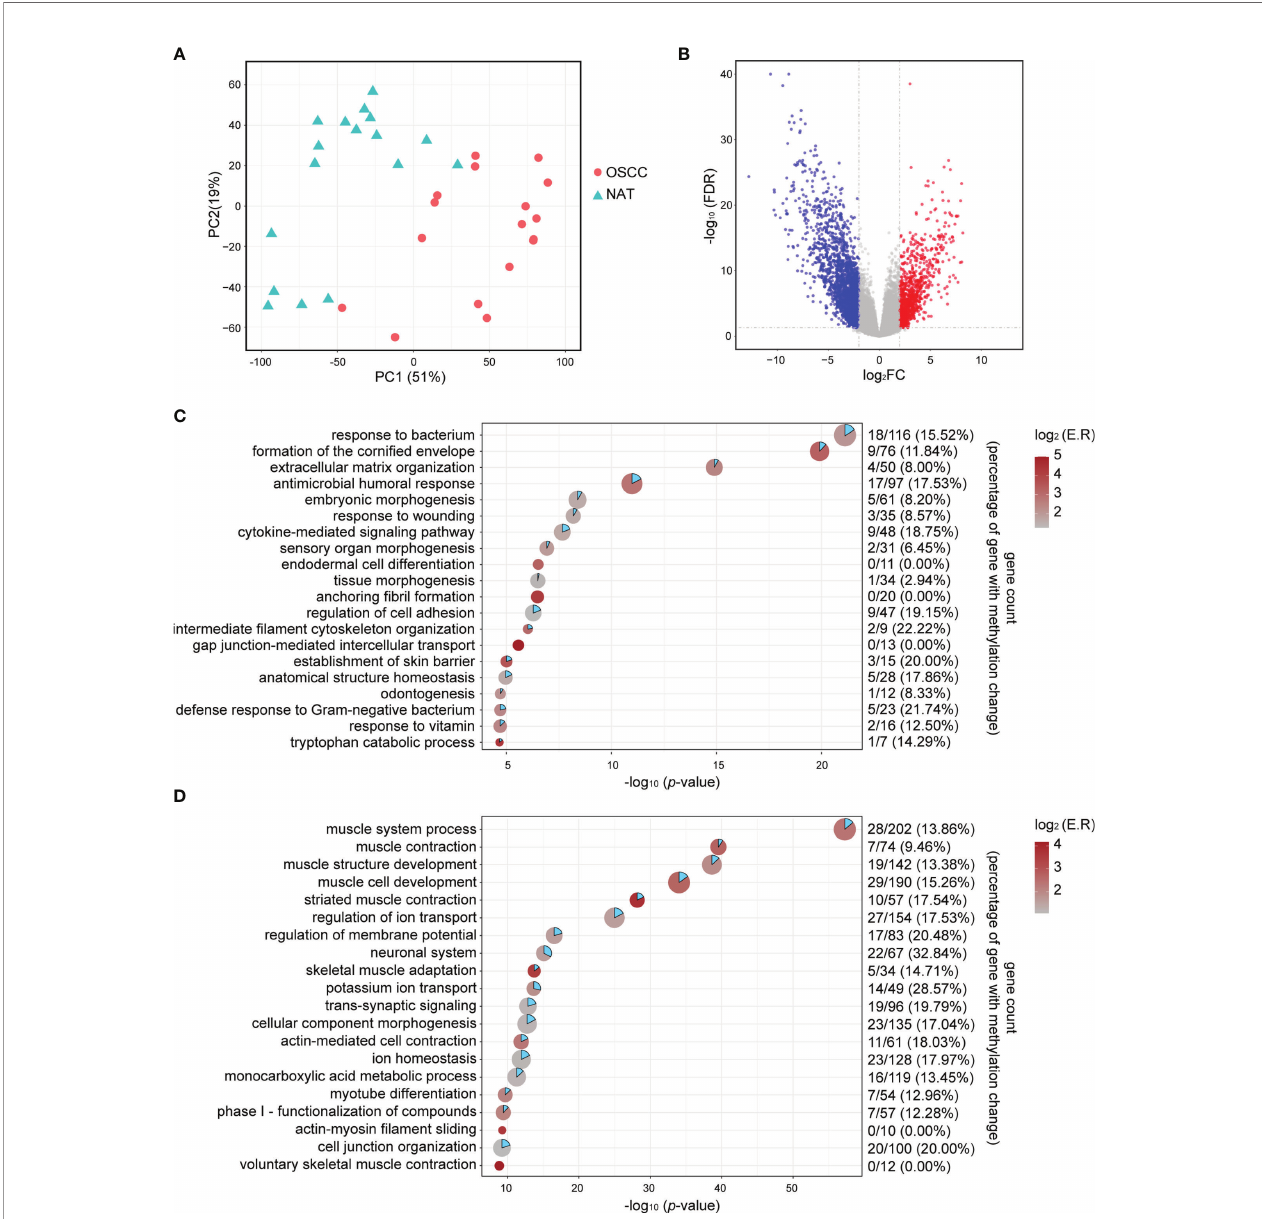
FIGURE 1 | Identi fi cation of DEGs. (A) PCA plots of RNA-seq data show the different characteristic of RNA expression patterns of OSCC tissues and NATs. Each dot indicates a sample. (B) Volcano plot visualizing the DEGs identi fi ed by the DESeq2 packages. The vertical dotted lines are positioned at log 2 FC of 2 or -2. The horizontal dotted lines are positioned at FDR = 0.05. (C) Point plot for the top 20 enriched functional clusters for upregulated genes. X-axis indicates -log 10 ( p -value), color indicates enrichment ratio, and size indicates gene counts in unique functional clusters. Gene count in the right panel indicates hypomethylated-upregulated genes/all upregulated genes (percentage of upregulated gene with methylation change). (D) Point plot for the top 20 enriched functional clusters for downregulated genes. X-axis indicates -log 10 ( p -value), color indicates enrichment ratio, and size indicate gene counts in unique functional clusters. Gene count in the right panel indicates hypomethylated-upregulated genes/all upregulated genes (percentage of upregulated gene with methylation change). log 2 FC, log 2 transformed fold change; NAT, normal adjacent tissue; FDR, Benjamini & Hochberg adjusted p